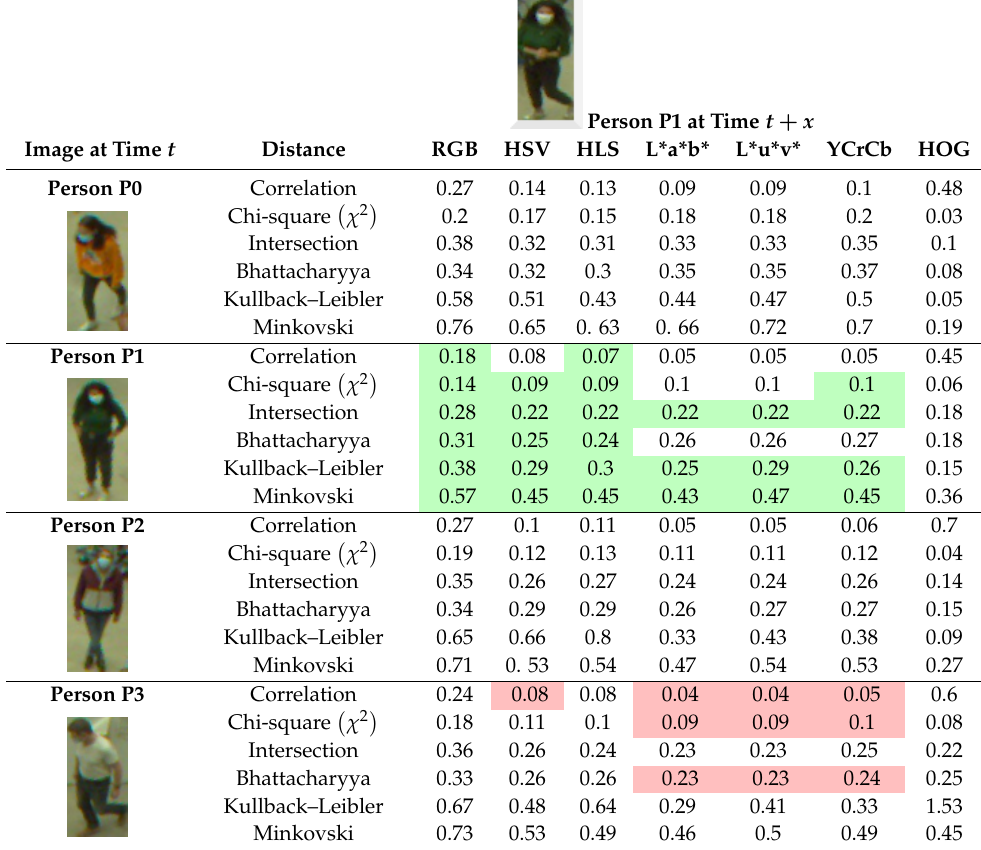
Table 3. Example of comparison of distance scores between several persons in two different frames as a function of the color space. The reference image on the third line is extracted in the image presented in Figure 2b whereas other persons are tied to the detected persons in Figure 2a. Note that images are unwrapped for